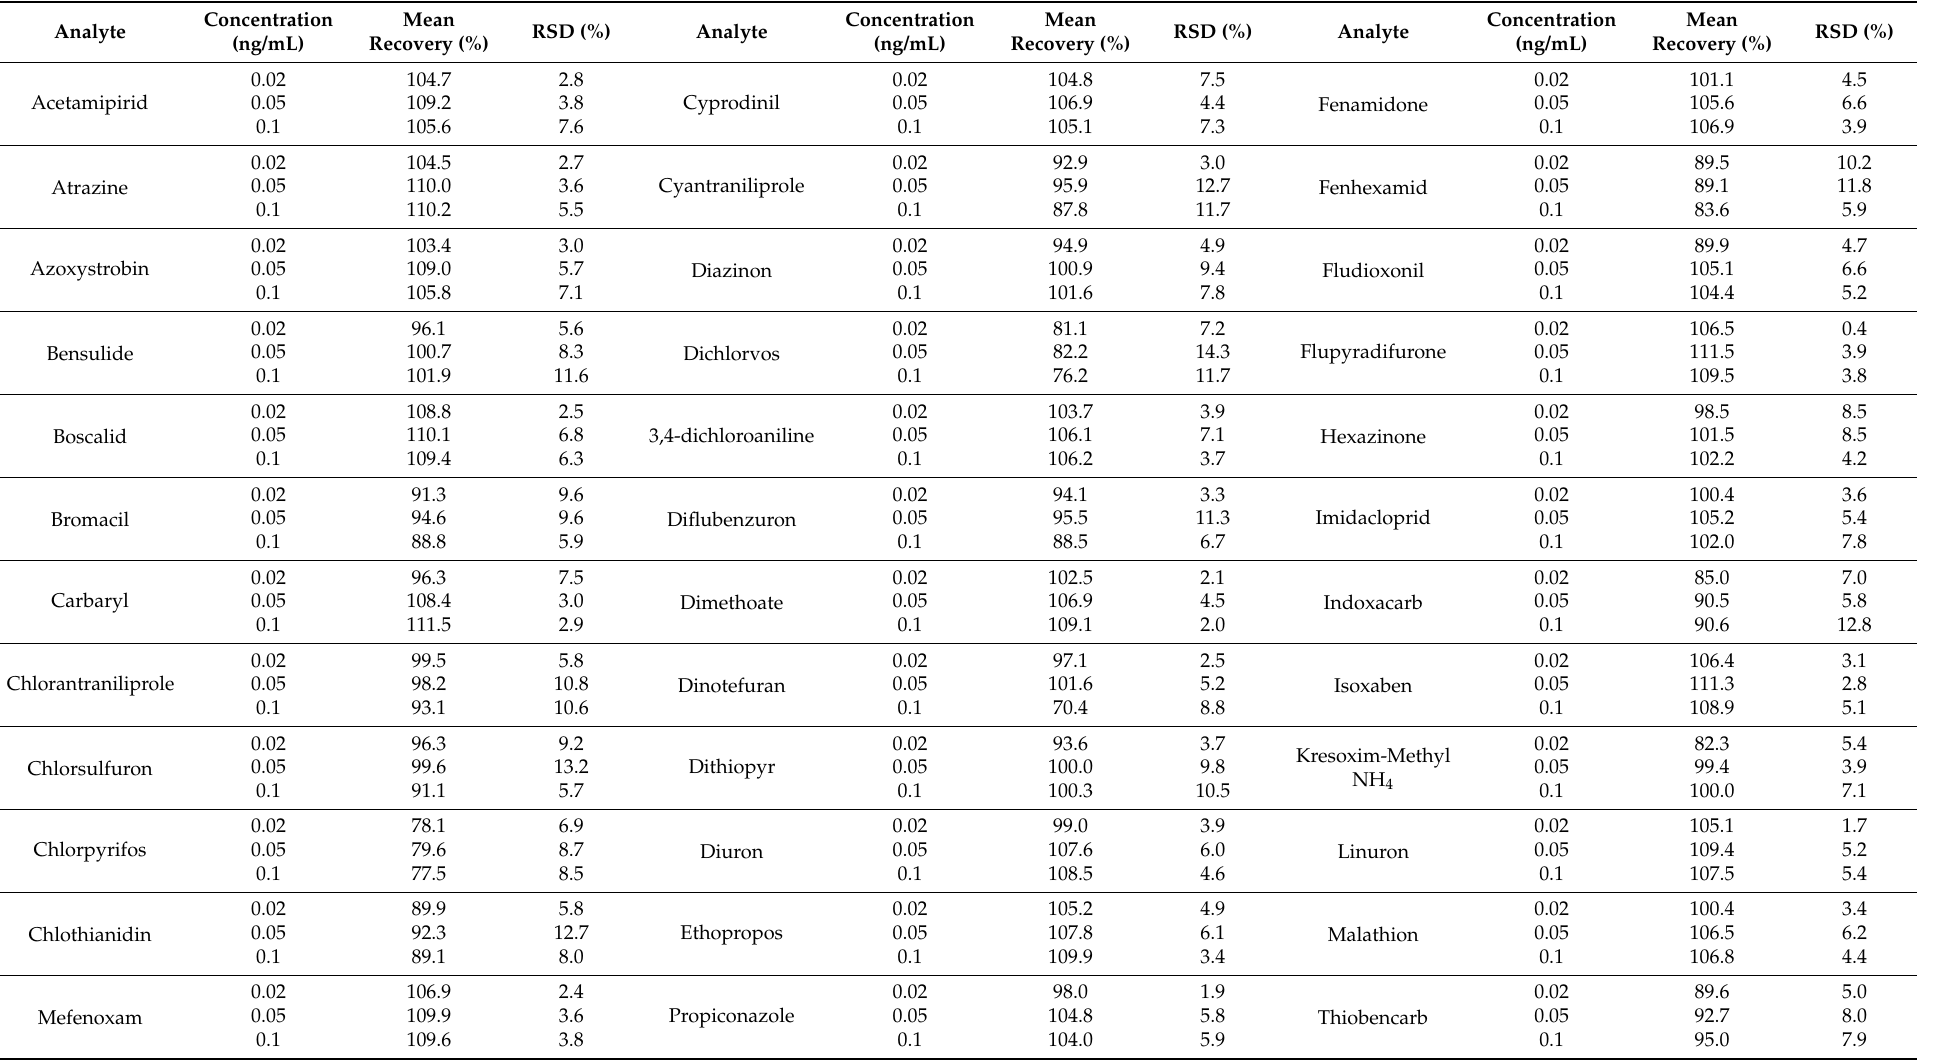
Table 4. Accuracy and precision of LC-MS/MS method for determination of 65 pesticides in surface water (n =